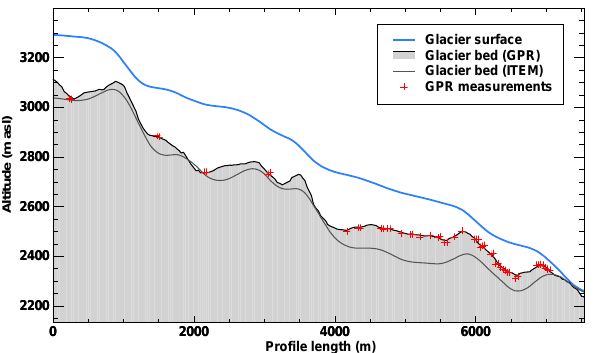
Fig. 11. Longitudinal profile along the central flow line of Glacier de Corbassi`ere (see Fig. 1). The thin black line refers to the glacier bed derived from the GPR measurements, the thin grey line to the bed computed by the ITEM and the blue line to the glacier surface. The red crosses mark the GPR-based ice-thickness measurements.